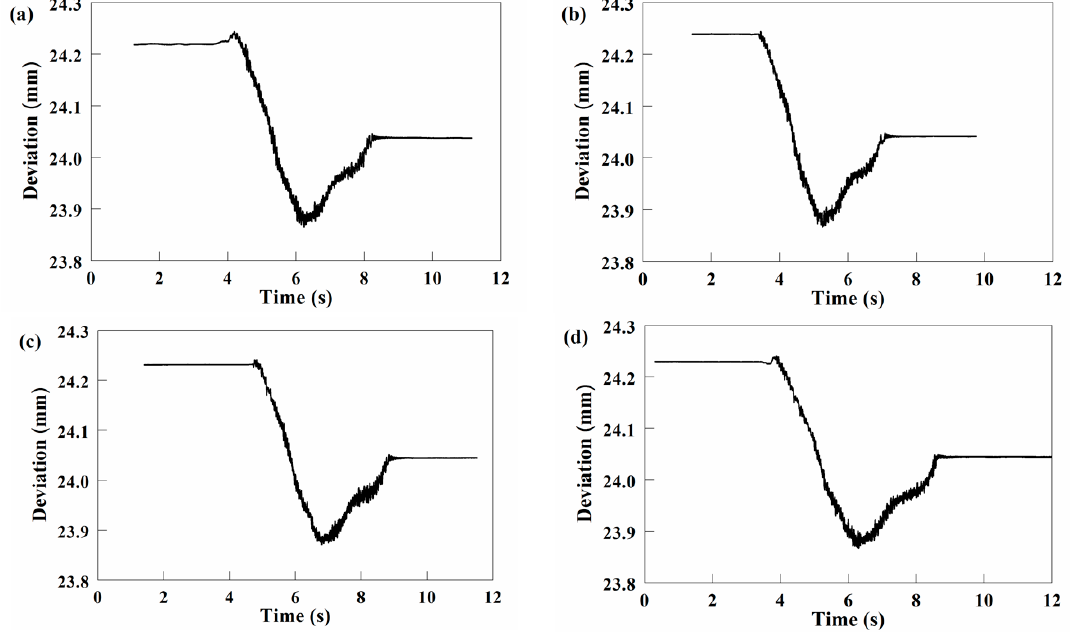
Figure 29. The measurements when PC is the measured surface ( a ) measurements 1 ( b ) measurements 2 ( c ) measurements 3 ( d ) measurements 4.